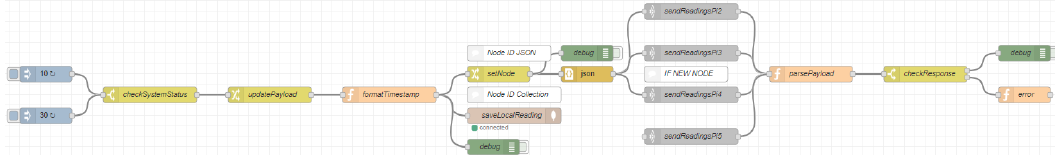
Figure 3. Reading flow.